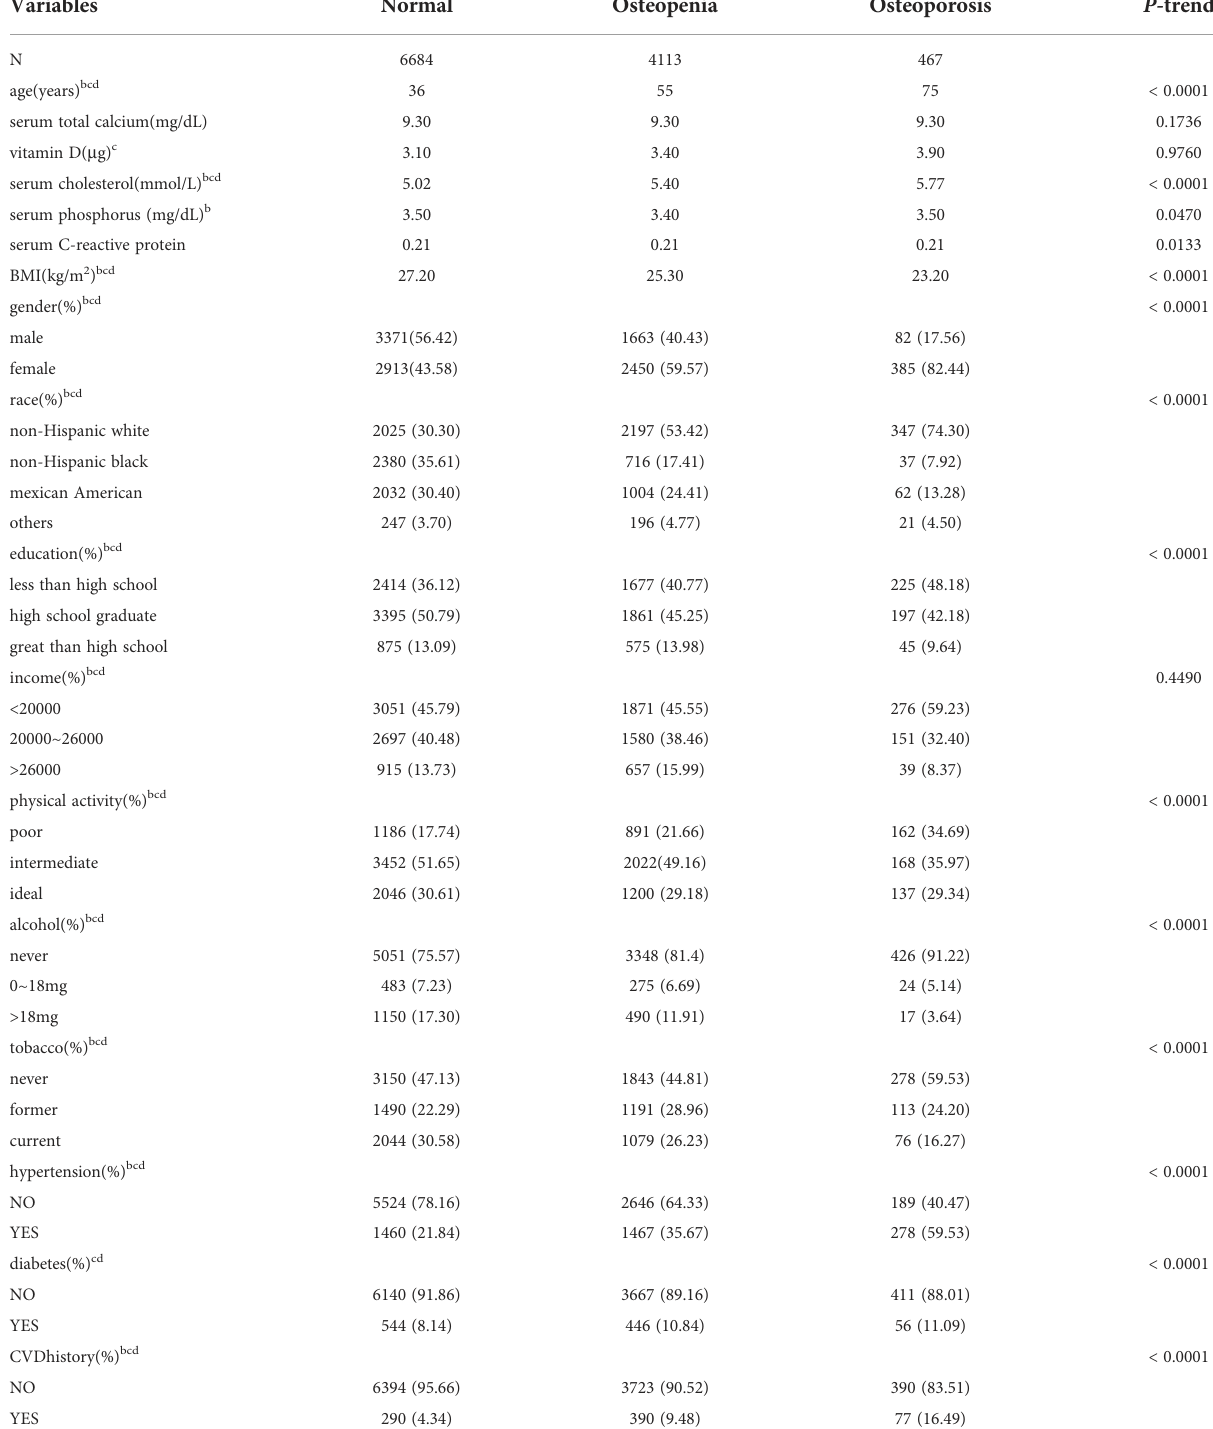
TABLE 1 Baseline characteristics according to the groups of bone mineral density(mg/cm2) a